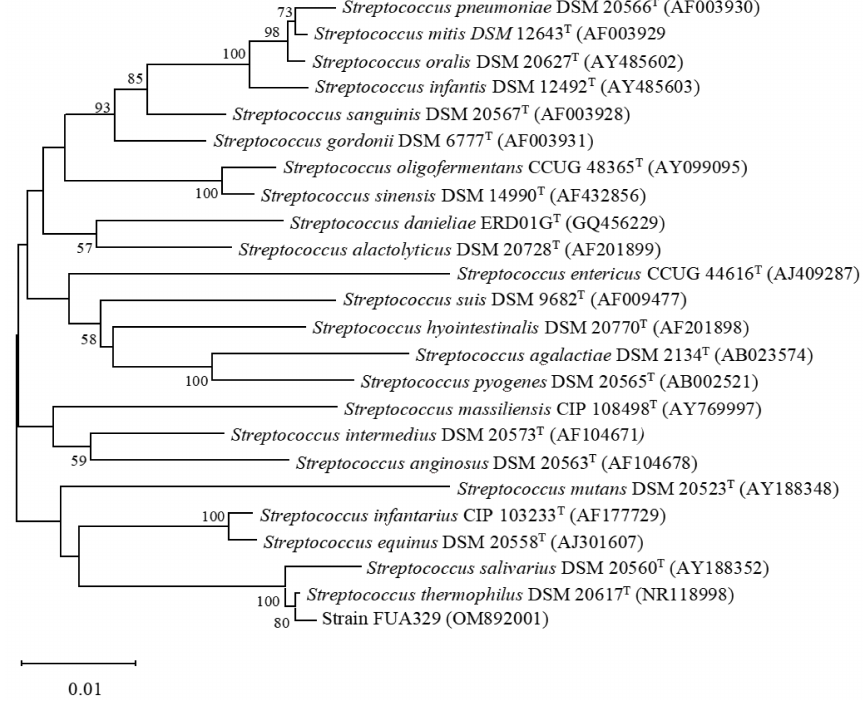
Figure 3. Phylogenetic tree of the strain FUA329 within the genus Streptococcus based on 16S rRNA sequences. The branching pattern was generated by using the maximum-likelihood method. Bootstrap values over 50% from 1000 replications are shown on the branches. The bar below the tree represents 1 nucleotide change per 1000